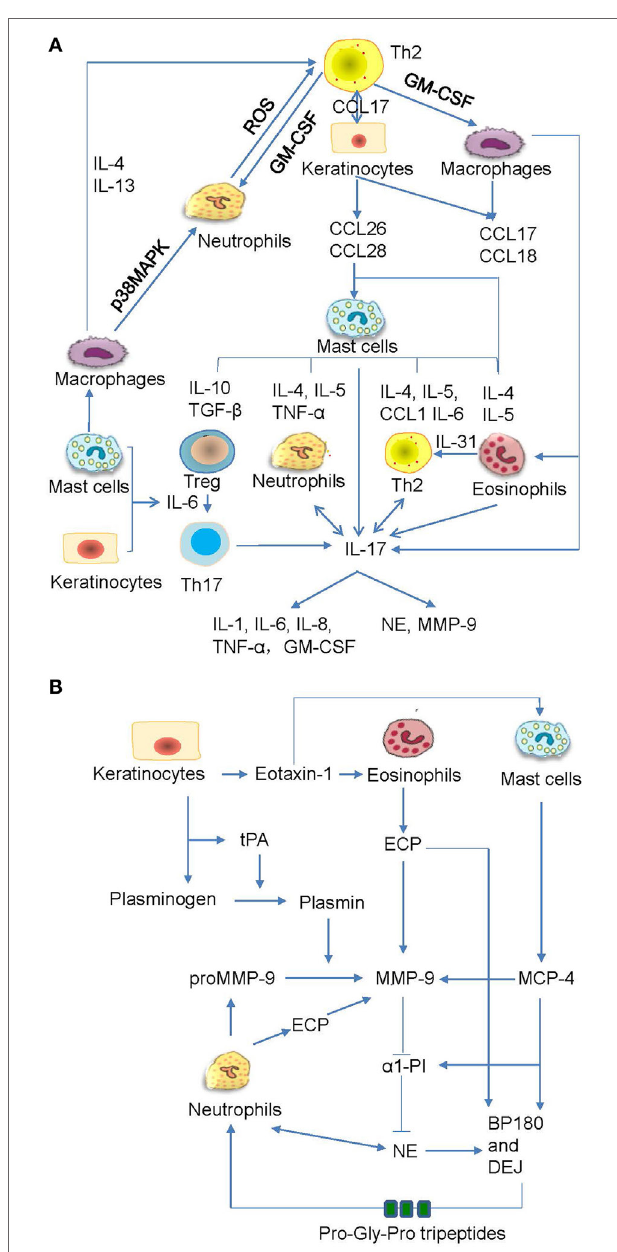
FigURe 5 | The crosstalk networks of the inflammatory cells and the proteases. (A) The autoactive Th2 cells secrete type II cytokines, which act on macrophages, keratinocytes, and fibroblasts and induce the chemotaxis of mast cells. The mast cells produce various cytokines and chemokines, which act on the regulatory T (Treg) cells, neutrophils, Th2, eosinophils, and macrophages. All these inflammatory cells can release interleukin (IL)-17, which not only act on neutrophils and Th2 but also prompt inflammatory response and proteases release. (B) The keratinocytes synthesize tissue plasmogen activator (tPA), which activates plasmin followed by the activation of matrix metalloproteinase (MMP)-9. The eosinophil cationic protein (ECP) and mast cell protease (MCP)-4 can also activate MMP-9. MMP-9 inhibits production of α 1-proteinase inhibitor ( α 1-PI) while promote generation of neutrophil elastase (NE). All these proteases act on BP180 and dermal– epidermal junction (DEJ). The cleaved BP180 can release pro-gly-pro tripeptides and attract